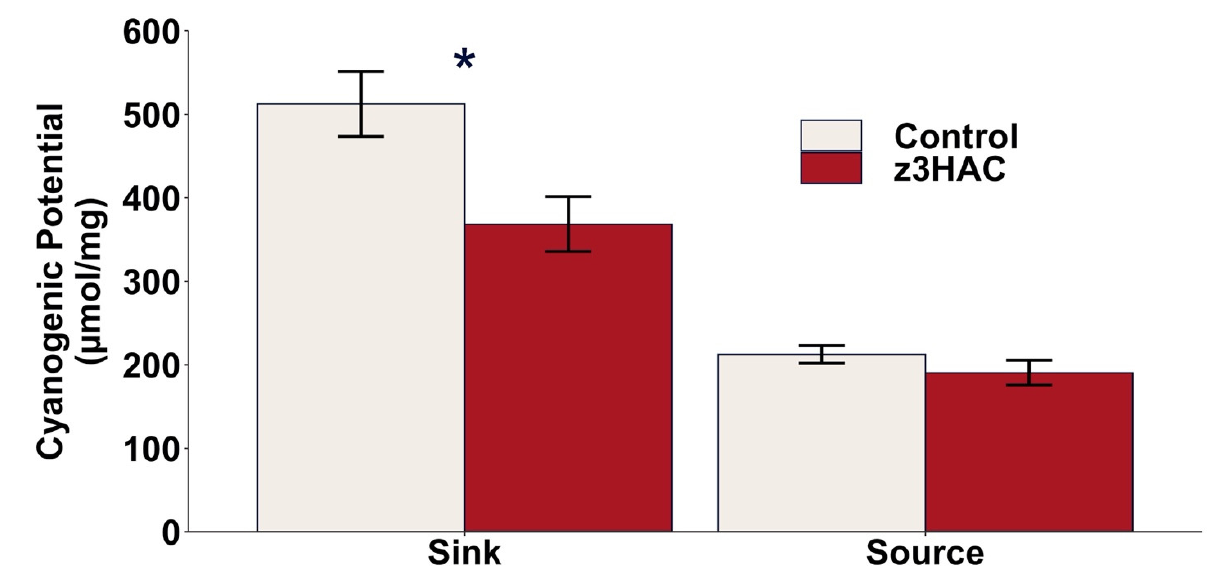
Figure 7. Cyanogenic potential in Phaseolus lunatus (Lima bean) as affected by z 3HAC exposure. Sink (immature) and source leaves were exposed to 10 ng/h z 3HAC (red bars) or left as a controls (grey bars). Points represent the averages +/ − SE and * indicates a p < 0.05 between control and z3HAC sink leaves.